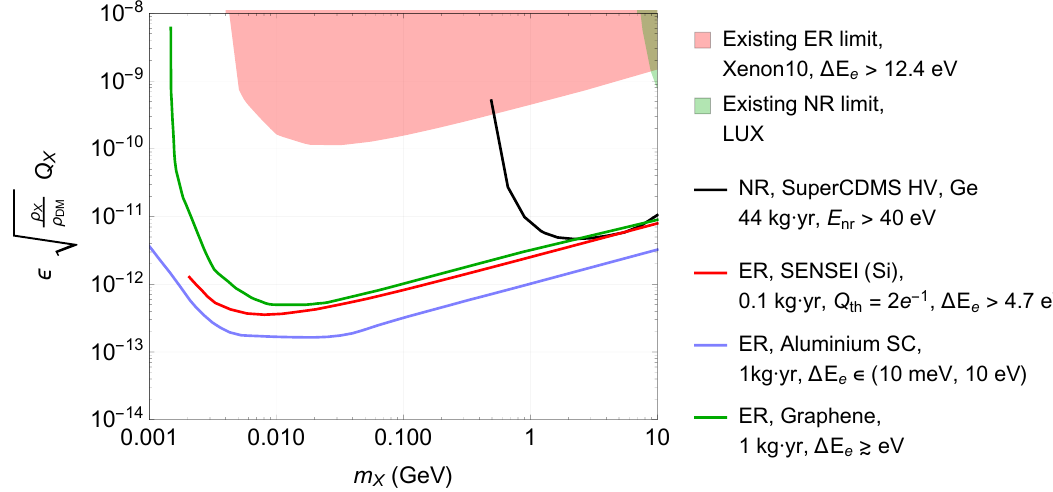
Figure 4 . Overview of current direct detection exclusion limits (shaded regions for Xenon10 and LUX) and the most relevant limit projections (lines) on sub-nano-charged DM, assuming the DM is distributed in a fully ionized, single-component standard halo. These limits do not directly apply to the MTH model due to the different velocity distribution and ionization of mirror baryons. ρ refers to the fraction of DM that is made up by the particular constituent X . Current Xenon10 limits from [146]. LUX [147] limits from [148]. We derived SuperCDMS NR limit projections using information from [149]. ER limit projections: SENSEI [150] limits from [148]. Superconducting aluminum target with 1 kg · year exposure from [151], Graphene target with 1 kg · year exposure from [152].